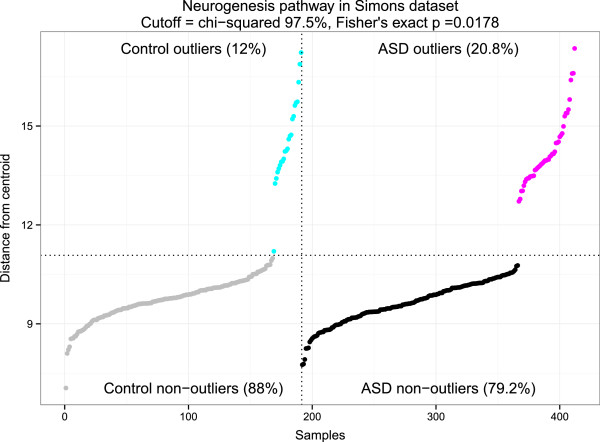
Neurogenesis outliers in the Simons data set. The y-axis is in units of Mahalanobis distance from the pooled centroid of cases and controls, and the x-axis is samples. One control sample was misclassified as an outlier due to the choice of χ0.9752 as the hard threshold.